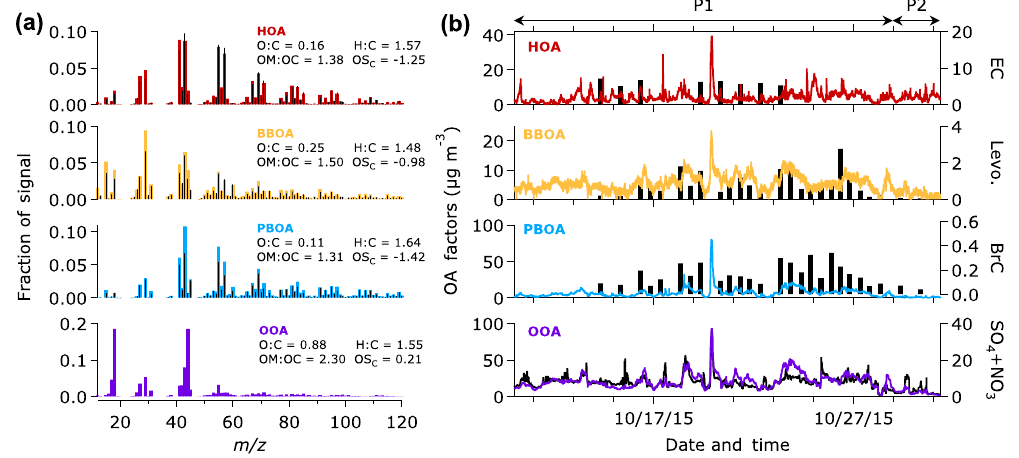
Figure 4. (a) Mass spectra of OA components resolved by the ME-2 analysis. Black bars represent the reference mass spectra of HOA and BBOA (Ng et al., 2011c) and peat burning aerosol (Budisulistiorini et al., 2017a) used as the constraints in the ME-2 analysis. The elemental ratios were estimated from signals of mass-to-charge ratios ( m/z ) 44 ( f 44 ) and 43 ( f 43 ) using the improved ambient elemental analysis method (Canagaratna et al., 2015). (b) Time series of OA factors observed in Singapore during the 2015 haze episode. Time series of EC, levoglucosan, the sum of brown carbon (BrC) constituents, and the sum of SO 2 − series of HOA, BBOA, PBOA, and OOA,